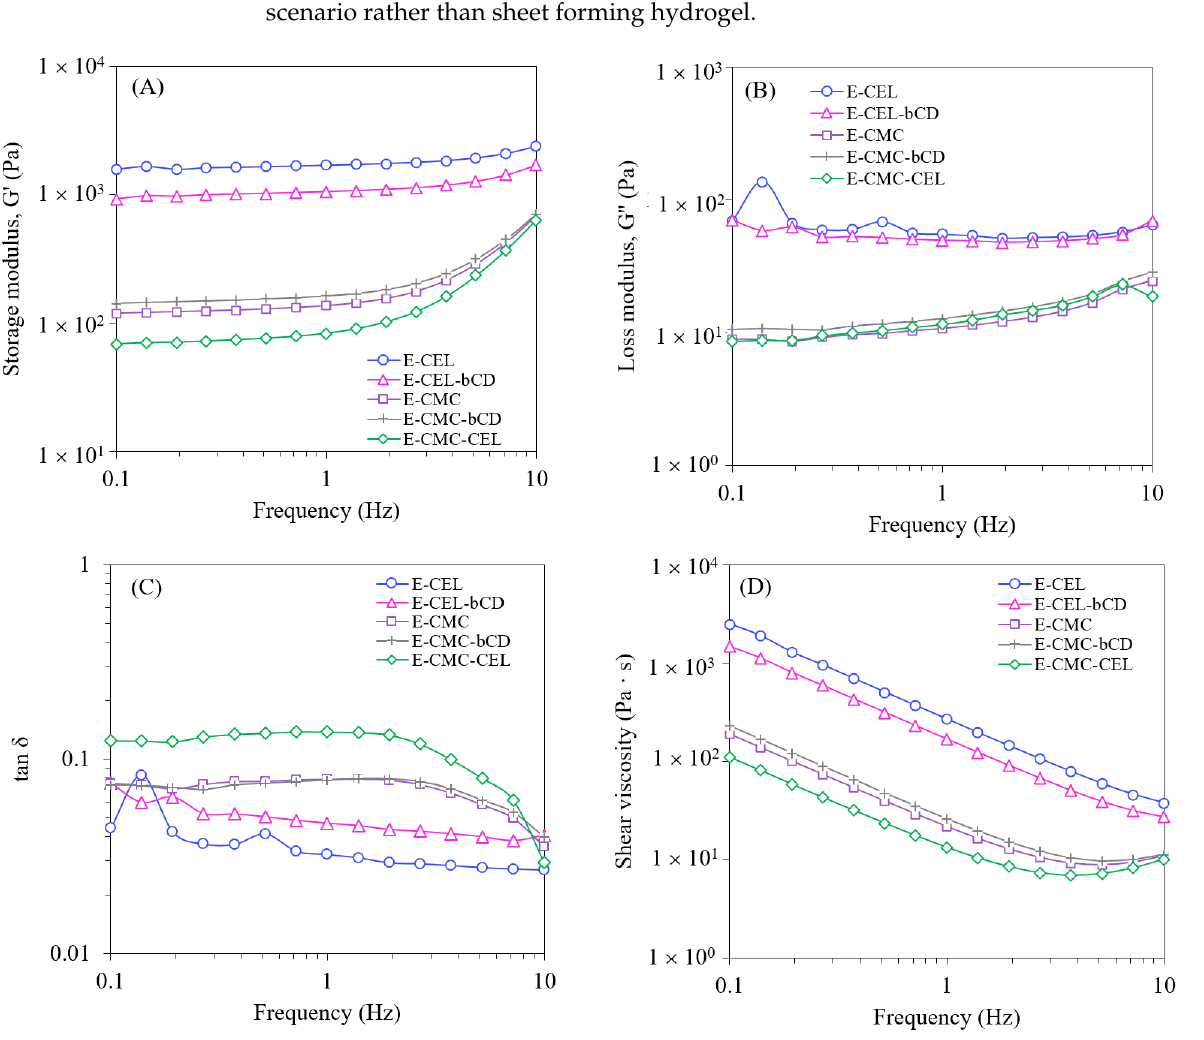
Figure 9. Rheological properties of ECH crosslinked cellulose, CMC, β CD-based hydrogel ( A ) Storage modulus, ( B ) Loss modulus, ( C ) tan δ and ( D ) shear viscosity of swelling gels.